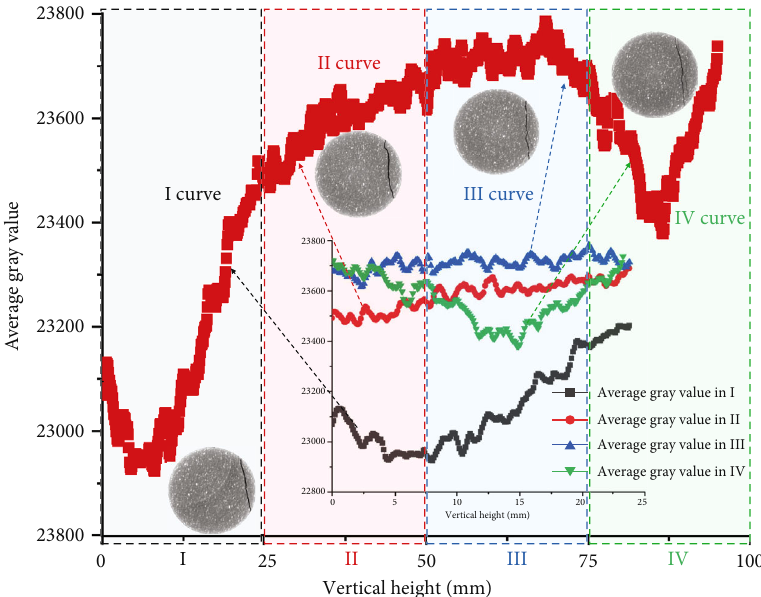
Figure 11: Variation curve of average gray value of fractured sandstone.